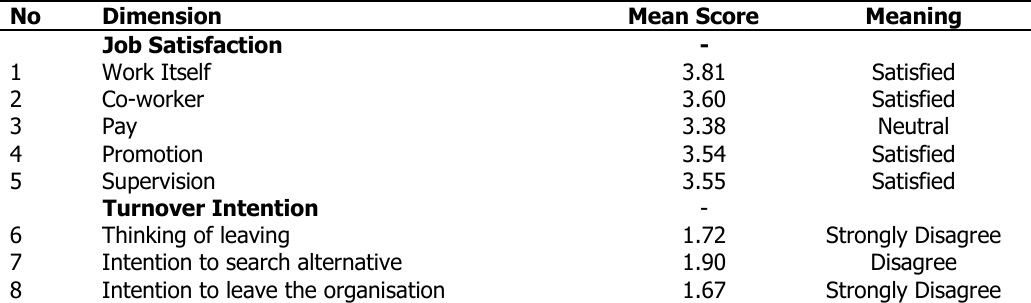
Table 3. Mean Score of Job Satisfaction and Turnover